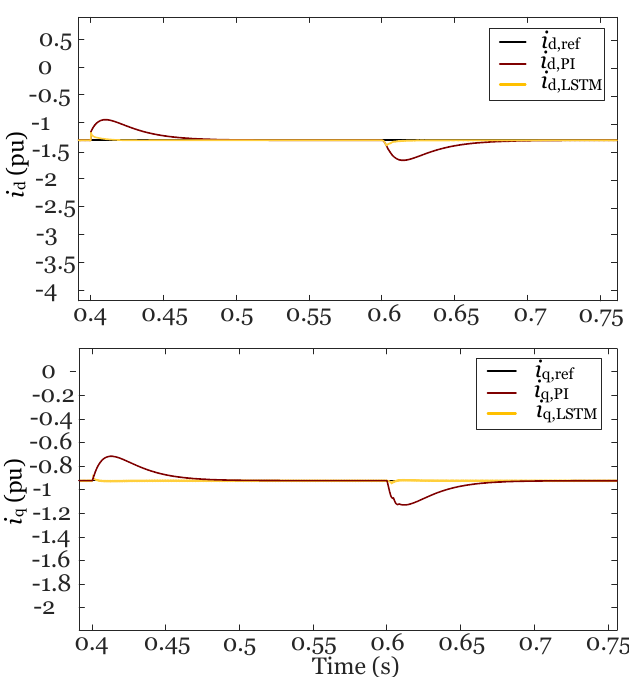
Figure 10. Controller response to a three-phase fault at